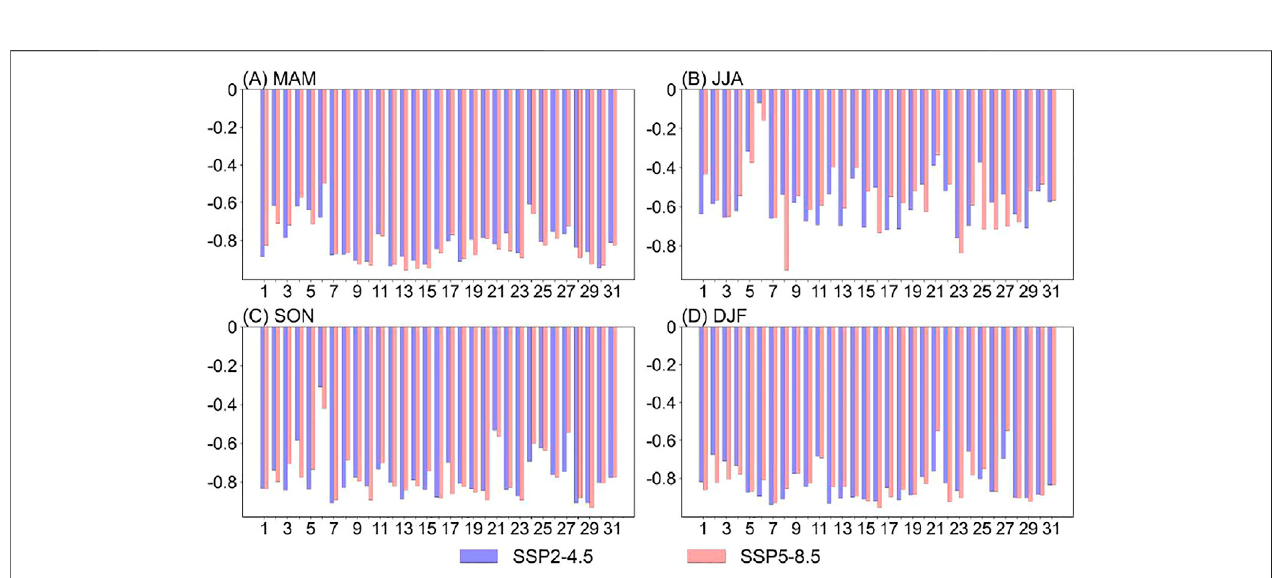
FIGURE 8 | AI-PI correlations in (A) spring, (B) summer, (C) autumn and (D) winter during 2050 – 2099 under SSP2-4.5 and SSP5-8.5. Numbers 1 – 30 represent individual models (see Table 1 for which model each number indicates). Number 31 represents MME.